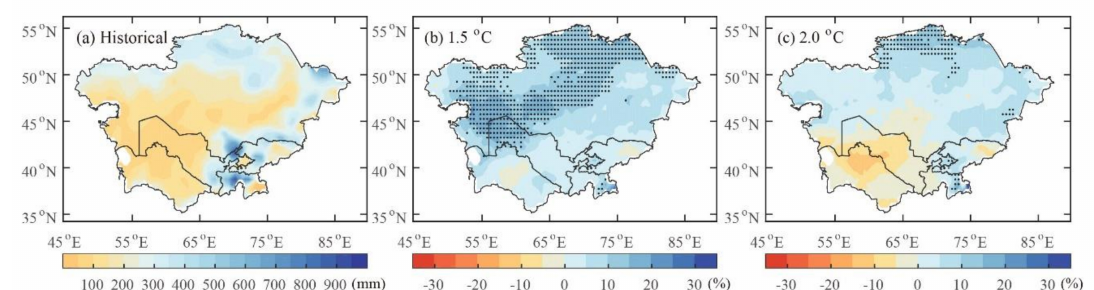
Figure 6. The spatial distribution of the mean annual total precipitation (PRCPTOT) in the reference period (1986–2005) ( a ) and the di ff erence under 1.5 ◦ C ( b ) and 2 ◦ C ( c ) global warming relative to the reference period. Dark gray dots indicate that the increasing trends are significant at the 1% level in these